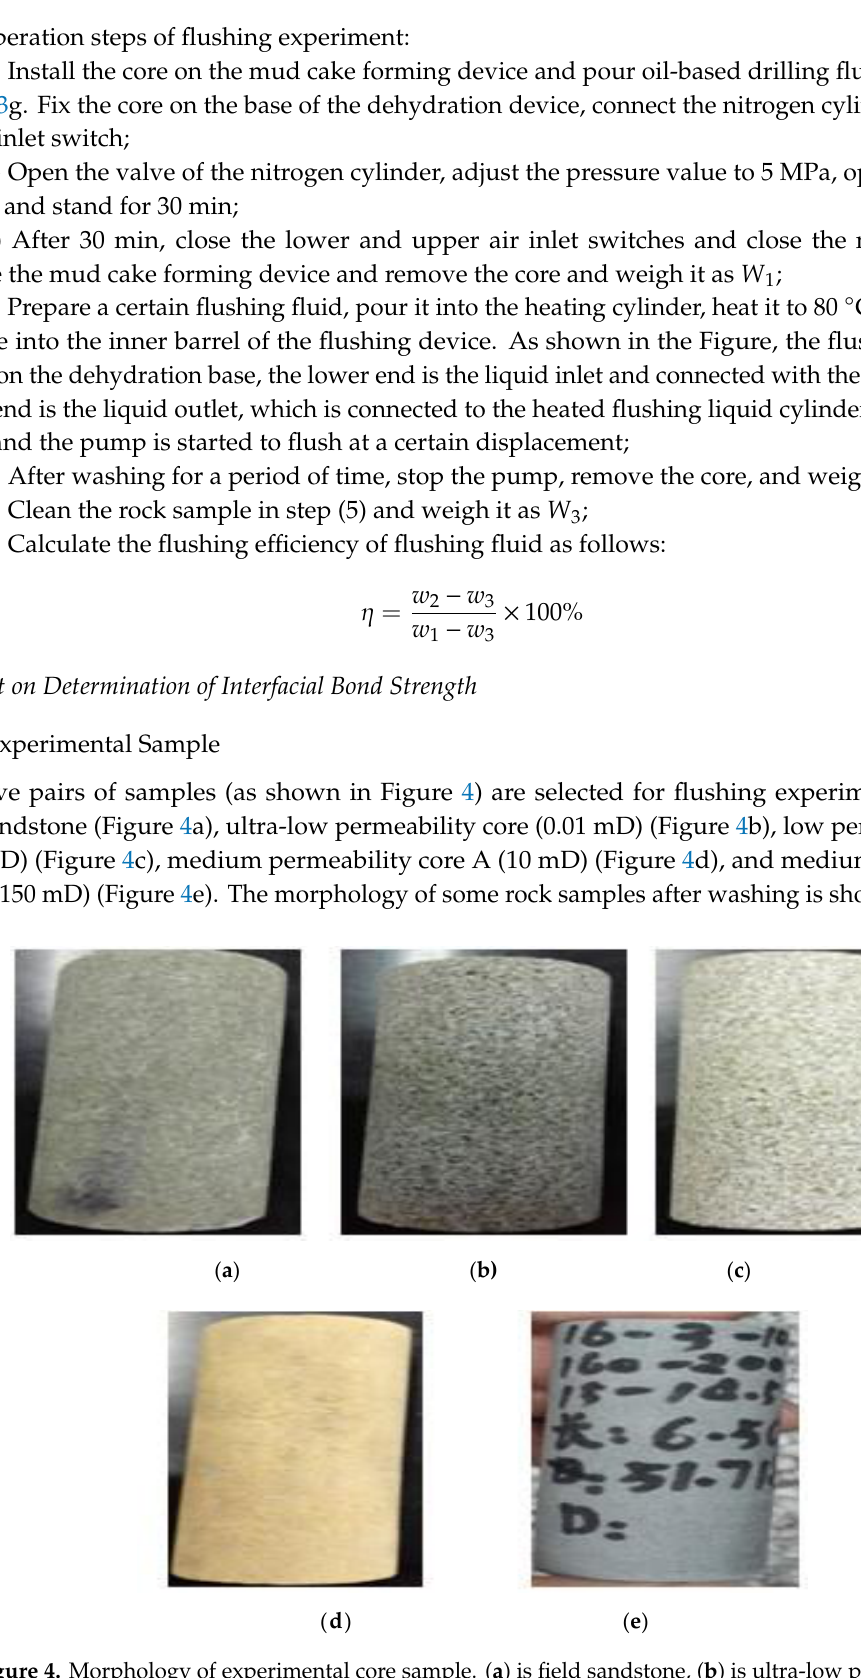
Figure 4. Morphology of experimental core sample. ( a ) is field sandstone, ( b ) is ultra-low permeability core, ( c ) is low permeability core, ( d ) is medium permeability core A, ( e ) is medium permeability core